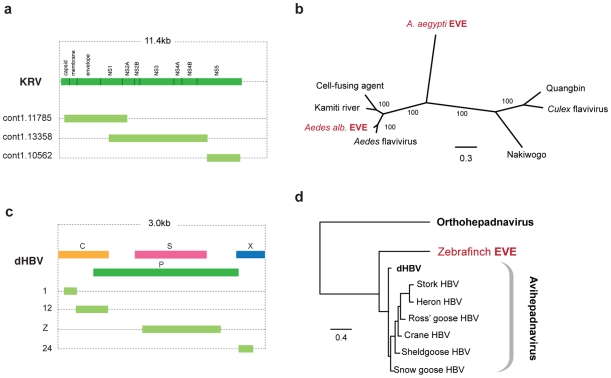
Genetic structures and phylogenetic relationships of EVEs related to flaviviruses and hepadnaviruses.(a) Genetic structures of non-overlapping flavivirus EVEs in the Aedes aegyptii genome. (b) Phylogenetic relationship of consensus flavivirus EVE sequences (spanning most of the region shown in (a) with exogenous and endogenous flaviruses. (c) Genetic structures of non-overlapping rtDNA (hepadnavirus) EVEs shown relative to the genus type species. Numbers to the left indicate the T. guttata chromosome on which the EVE is present. (d) Phylogenetic relationships of consensus zebrafinch EVEs and representative exogenous viruses. Avihepadnavirus genus is rooted on Woodchuck HBV (Orthohepadnavirus). All ML phylogenetic trees were inferred from amino acid alignments using the best-fitting model of evolution. Support for trees was evaluated using 1,000 nonparametric bootstrap replicates. Abbreviations: KRV = Kamiti River virus, HBV = hepatitis B virus, dHBV = duck hepatitis B virus.